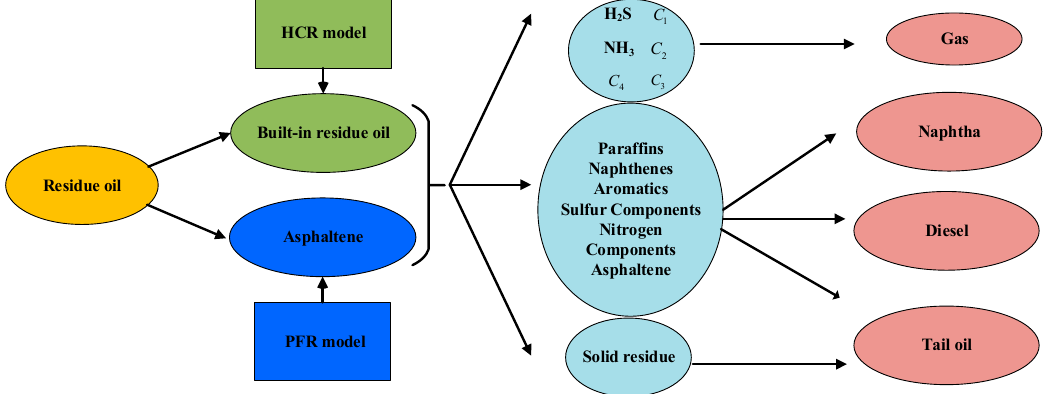
Figure 2. The reaction mechanism of the two-reactors model for residue reactions process. (HCR: hydrocracker reactor; PFR: plug flow reactor).